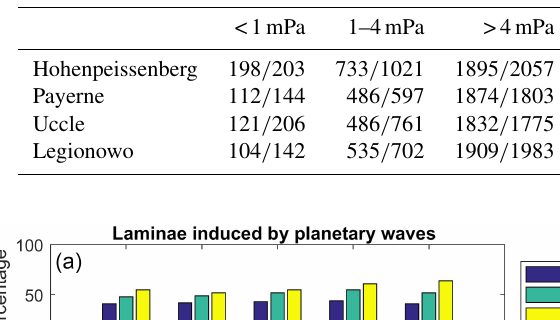
Table 3. Average lamina depth (m) in the selected lamina size in- tervals at the European middle-latitude stations for the vertical res- olution below 100m (before slash – advective laminae; after slash – gravity wave laminae).